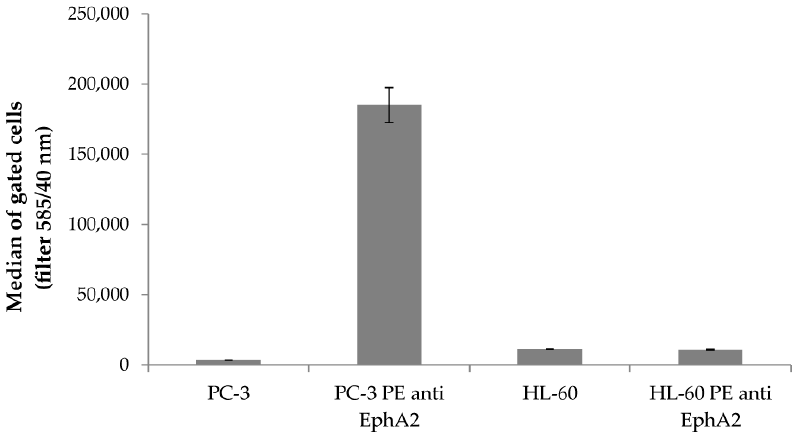
Figure A5. Flow cytometry analysis of EphA2 expression. Solubilized PC-3 cells at a concentration of